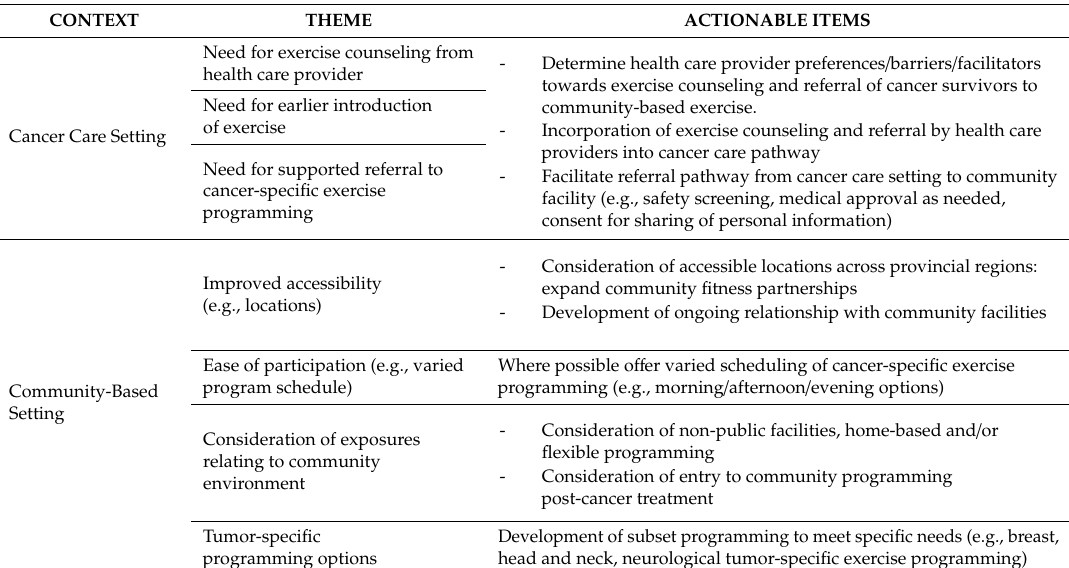
Table 4. Translation of themes to actionable